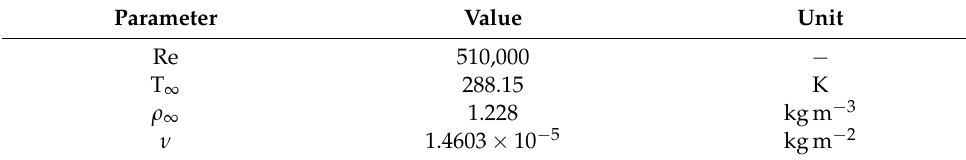
Table 5. Flight conditions for validation